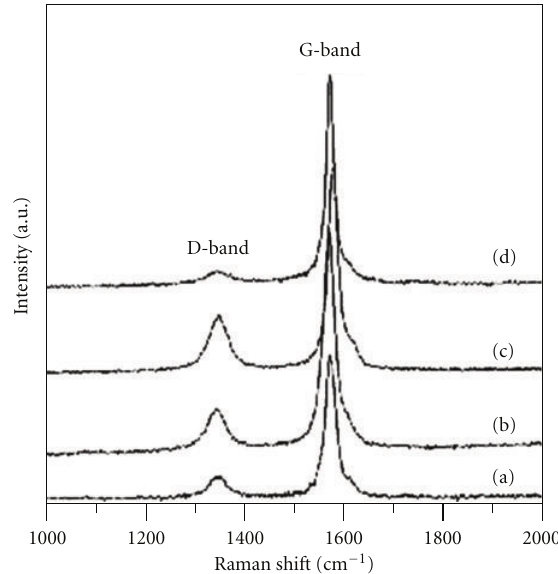
Figure 3: Raman spectra of di ff erent carbon counter electrodes: (a) MCMB, (b) C1, (c) C2, and (d)